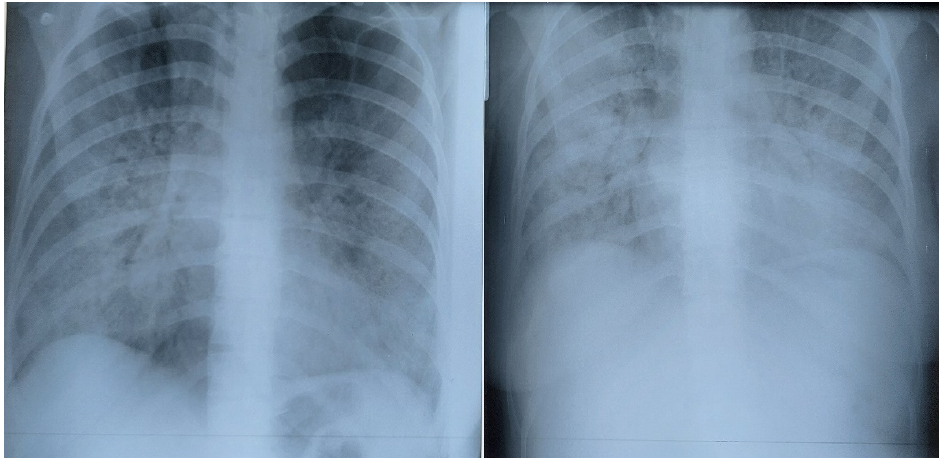
Table 3. qSOFA scores in the two groups: median values and interquartile range.